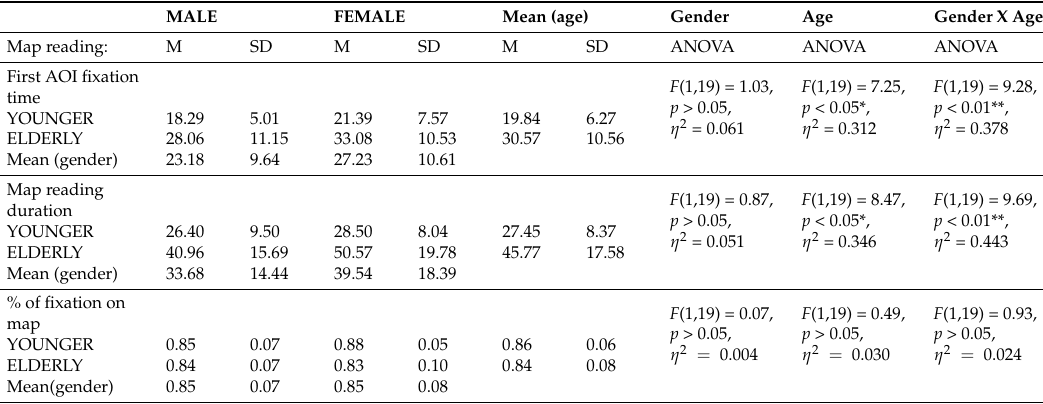
Table 2. Descriptive and inferential statistics for Task 1